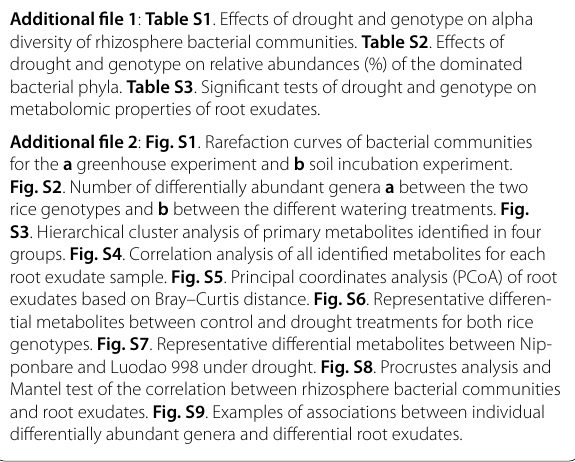
Fig. S2 . Number of differentially abundant genera a between the two rice genotypes and b between the different watering treatments. Fig. S3 . Hierarchical cluster analysis of primary metabolites identified in four groups. Fig. S4 . Correlation analysis of all identified metabolites for